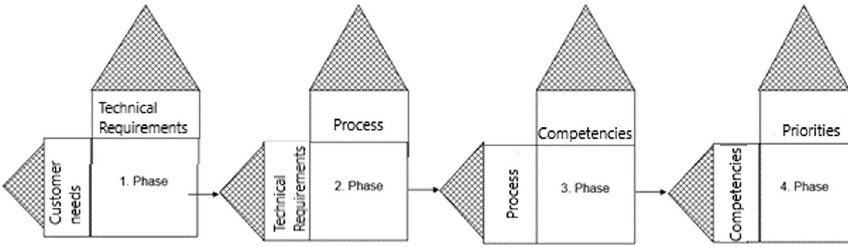
Fig. 2 QFD-based phases of financial innovation priorities